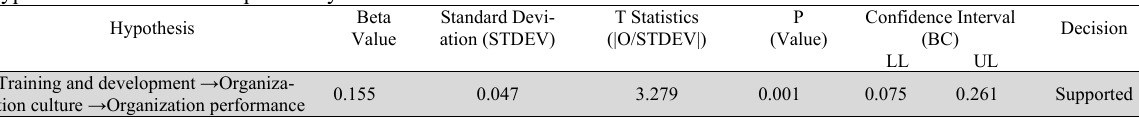
Beta Standard Devi- Value ation